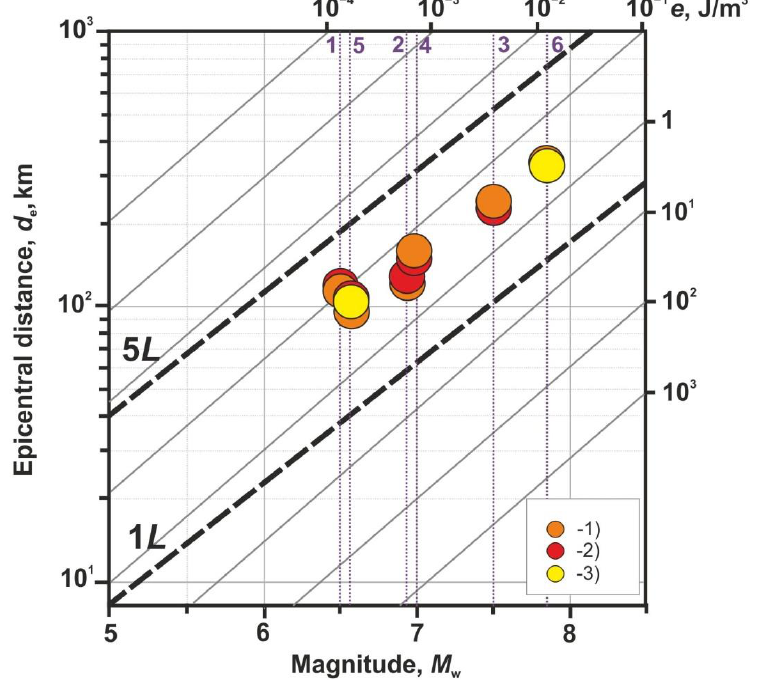
Figure 5. Distribution of precursory anomalies in ion content of underground water from flowing wells (1) GK-1, (2) M-1, (3) G-1 as function of earthquake parameters: magnitude M w , epicentral distance d e , and specific density of seismic energy e . Thin vertical dotted lines indicate earthquakes preceded by anomalies in ion content of underground water in two to three wells, earthquake numbers correspond to numbers in Table 2, Figure 3. Lines 1 L , 5 L show one and five linear sizes of earthquake source depending on magnitude M w [20].